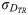
Standard deviations of simple and conditional trait differences and their correlation.Standard deviations (Left) of σDTR (dash) and σDTR|DCR=0 (solid) relative to σDTC (100% dot line), and correlation coefficients (Right) of ρDTC,DTR|DCR=0 (dash) and ρDTR,DTR|DCR=0 (solid), as functions of σg: σe.